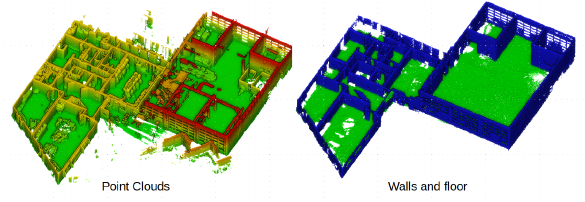
Figure 3: Left: Point clouds of the first floor, Right: detected walls and